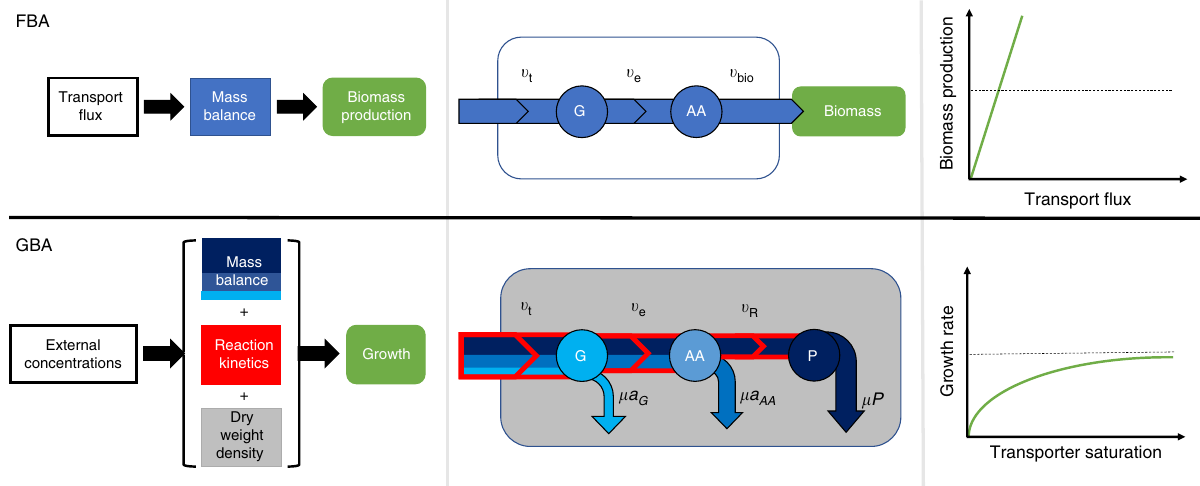
Fig. 1 A comparison of fl ux balance analysis (FBA, top) and growth balance analysis (GBA, bottom) for a simple schematic model. A nutrient G is taken up through a transporter t at rate v t and is then converted by an enzyme e with rate v e into a precursor for protein synthesis, AA . In FBA, AA is equated with the biomass, the production of which is maximized while enforcing the stationarity of internal concentrations (blue); this leads to a linear dependence of growth rate on uptake fl ux. In GBA, AA is converted further into total protein P by a ribosome R , where P represents the sum of the three proteins ( t , e , R ). GBA maximizes the balanced production of the cellular composition with growth (blue), offsetting the dilution of the cellular components ( G , AA , P ) with the growth rate μ indicated by the blue arrows. The reaction fl uxes are constrained by non-linear reaction kinetics (red) and a limit on cellular density (dry mass per volume, gray); this leads to a non-linear dependence of growth rate on nutrient